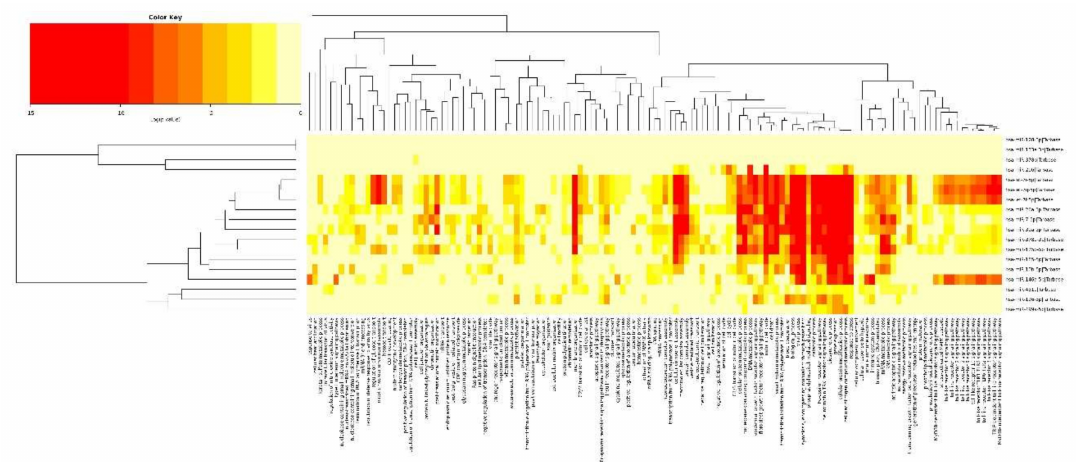
Figure 5. The identified Gene Ontology biological processes related to 18 microRNAs commonly detected in both breeds as differentially expressed between pigs with various muscle masses (DIANA-miRPath v3.0, DIANA-Lab, Athens, Greece).